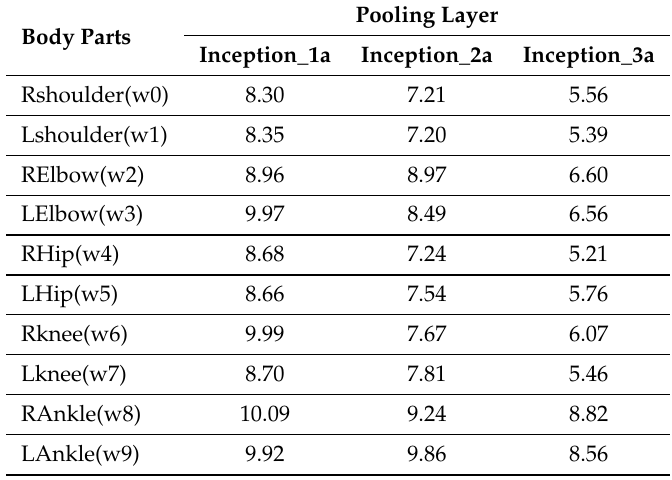
Table 12. The learned weights of ten body parts at different pooling layers. The initial weight parameter of each body part region was set to